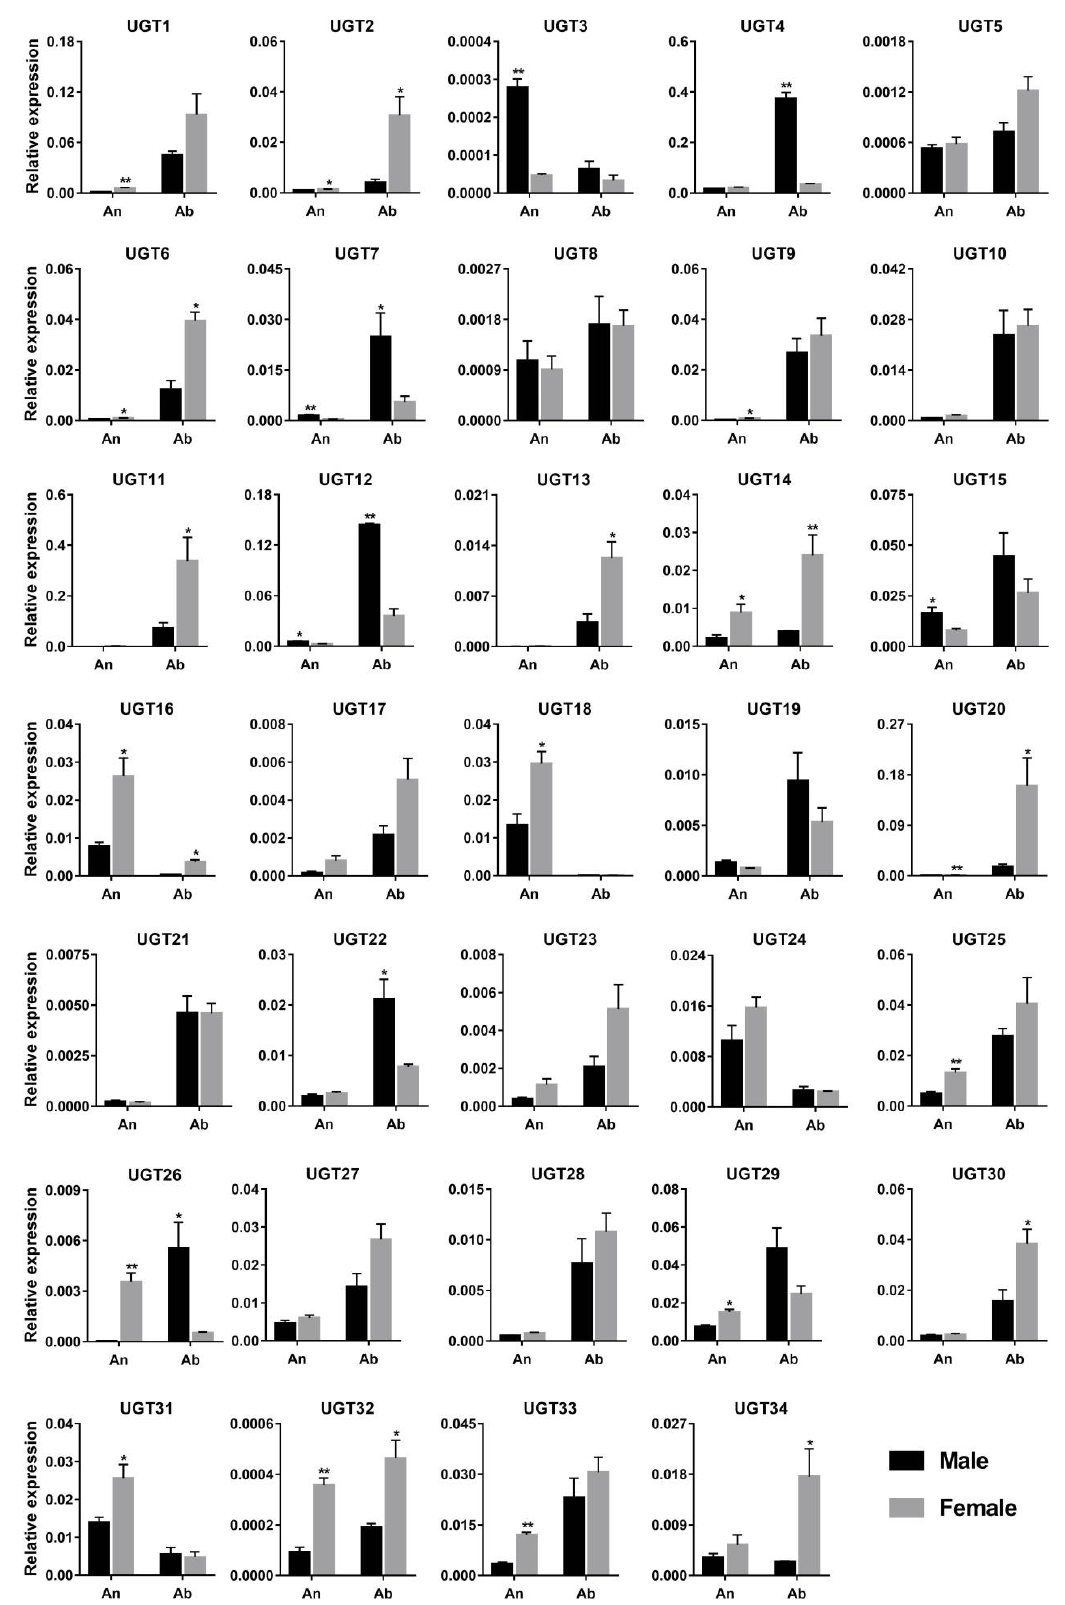
Figure 4. qPCR analysis of 34 UGT genes in antennae (An) and abdomens (Ab) of both sexes from P. antennata . Error bars represent the standard errors of three biological replicates. Asterisks denote significant differences in gene expression levels between female and male tissues (* p < 0.05, ** p < 0.01).